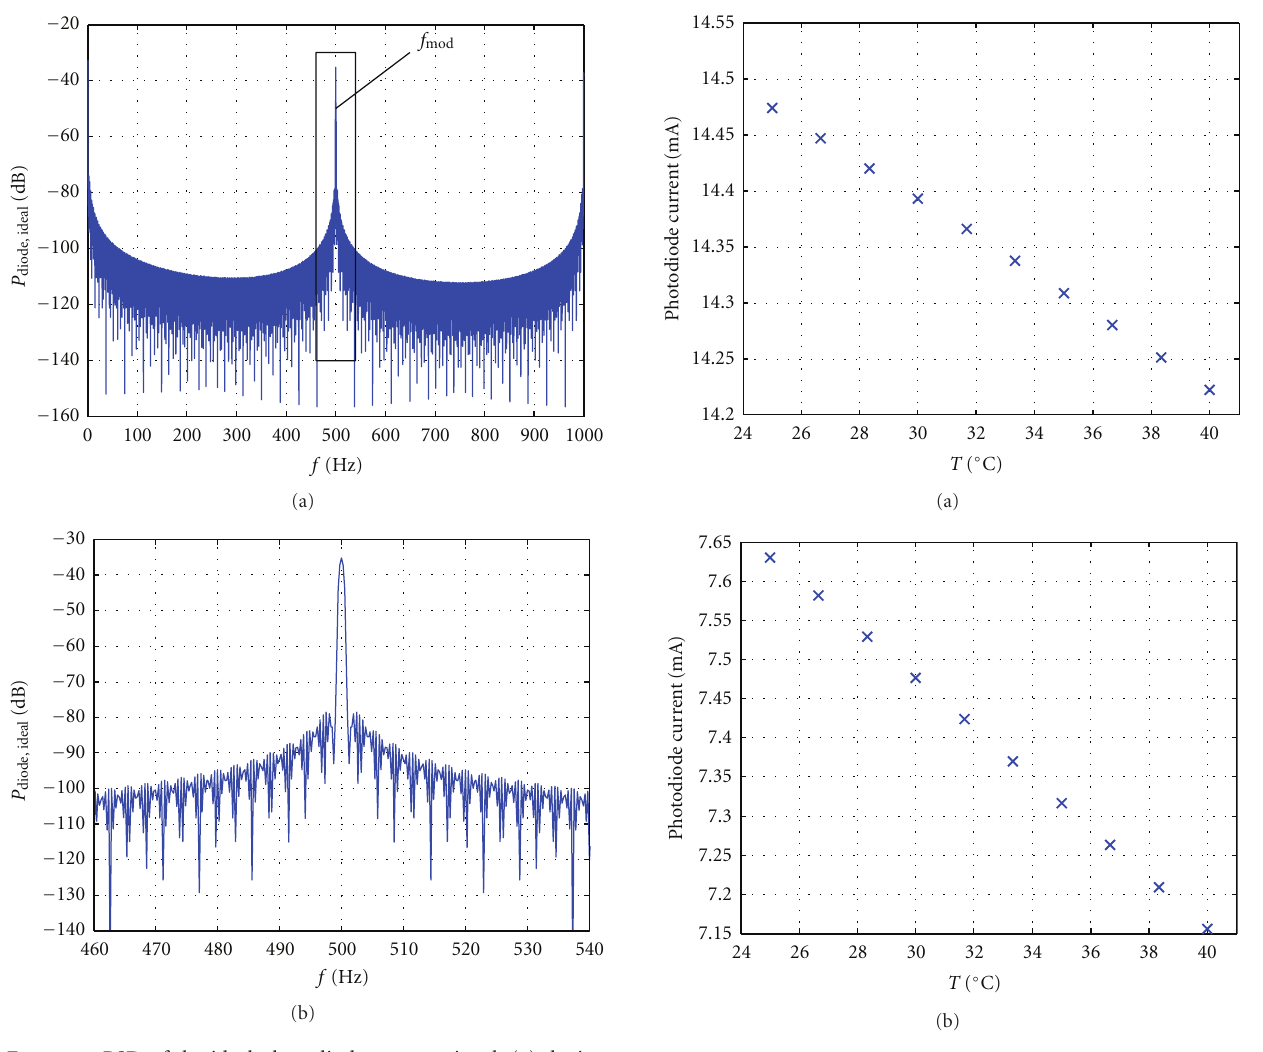
metamaterial for a constant concentration of c glucose =